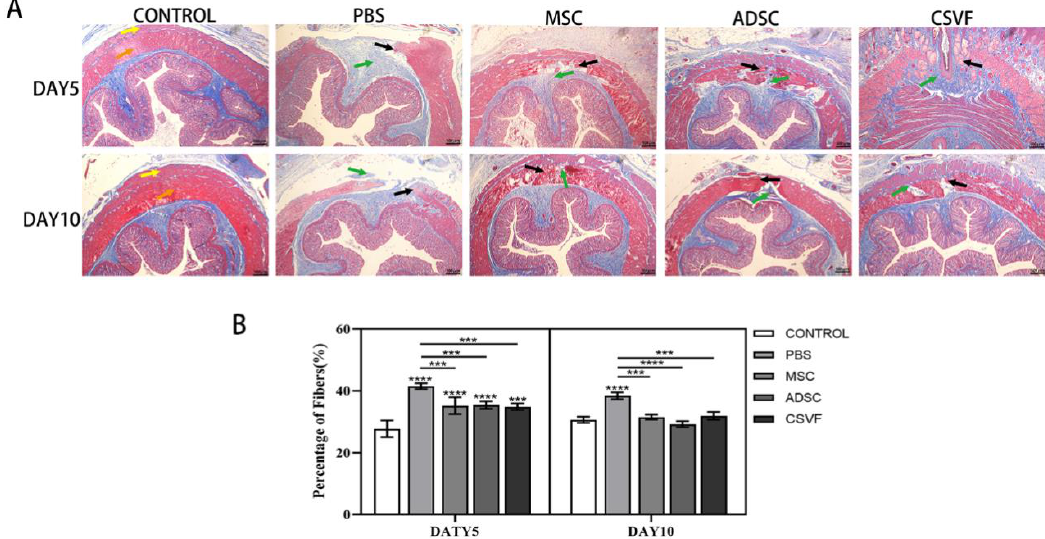
Figure 6. ( A ) Masson Trichrome staining of the injury site in the control group, PBS group, MSC group, ADSC group and CSVF group after 5 and 10 days of treatment. Yellow and orange arrows represent the external anal sphincter and internal anal sphincter, respectively, green arrows point to regenerated connective tissue, while black arrows point to regenerated muscle. ( B ) Percentage of fibers in the control group, PBS group, MSC group, ADSC group, and CSVF group after 5 and 10 days of treatment. An **, *** or **** without a horizontal line indicates a statistical difference in comparison to the control group, and an **, *** or **** with a horizontal line indicates a statistical difference between the groups at the horizontal ends. Significant differences between groups were expressed as **** p < 0.0001, *** p < 0.001, ** p < 0.01, and * p < 0.05.